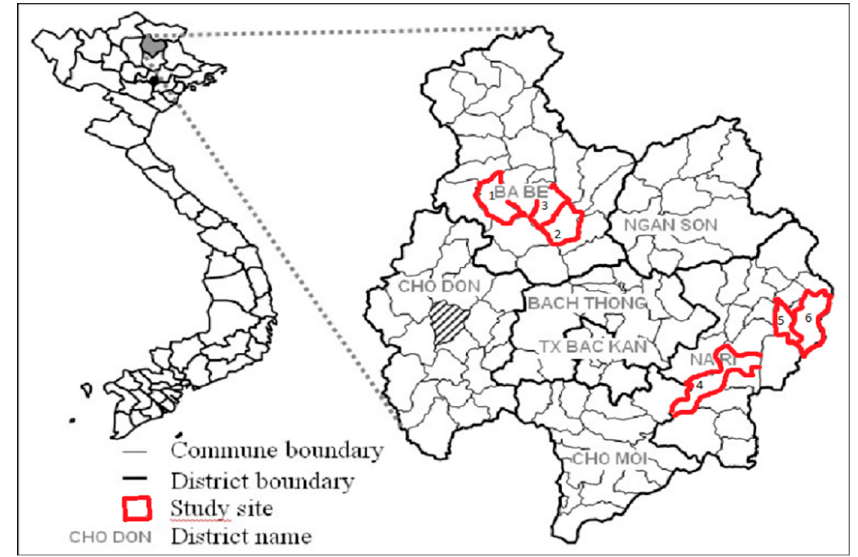
Figure 1. Map of the study area, source [23].